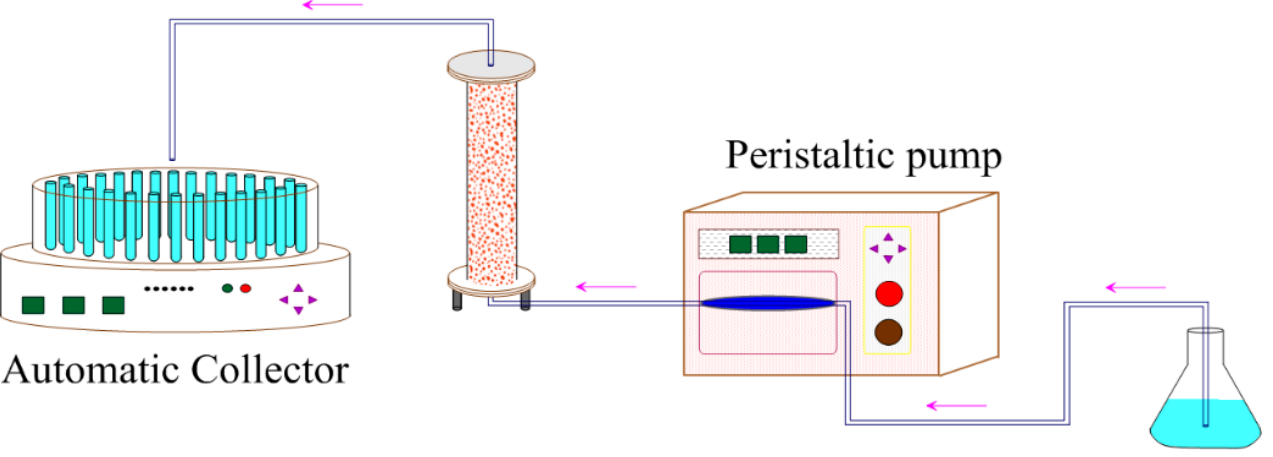
where C 0 is the initial concentration of CIP or NOR (mg · L − 1 ); C t is the concentration at time point t (mg · L − 1 ); N 0 is the adsorption capacity of the adsorbent (mg · L − 1 ); Z is the fixed-bed thickness of the adsorbent (GN) packed in column (cm); ν is the flow velocity